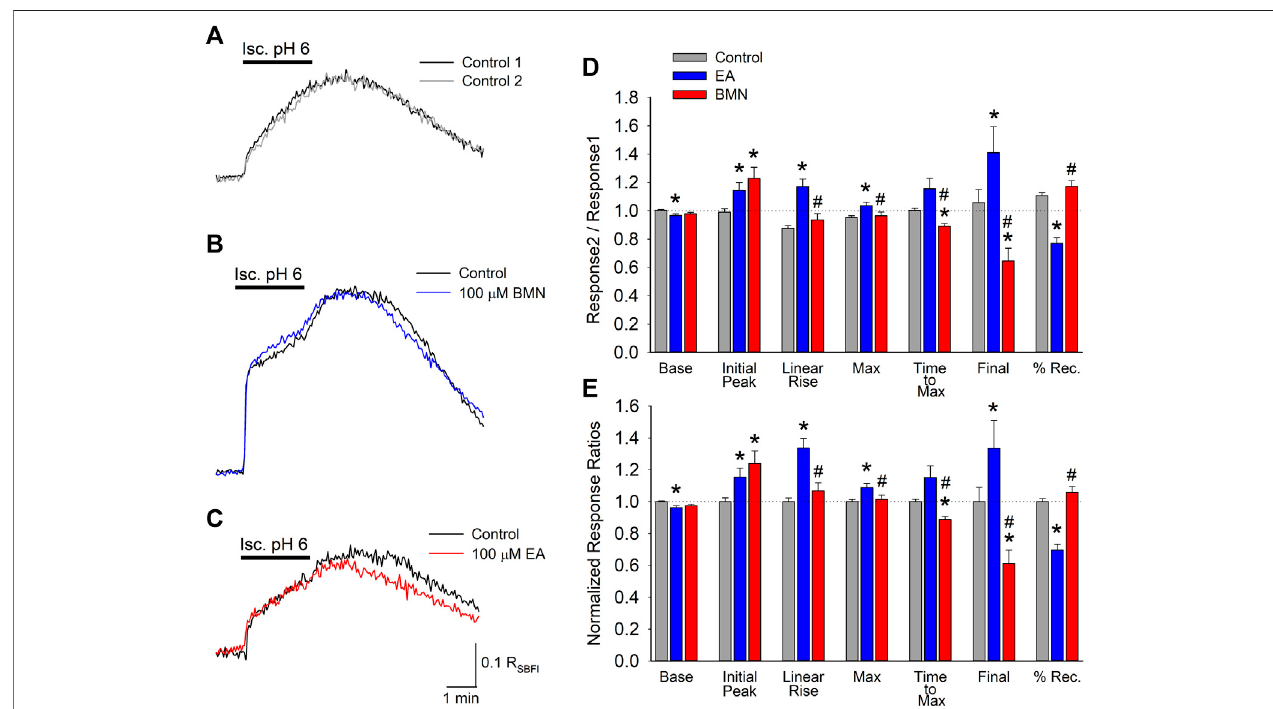
FIGURE2| Increasesin[Na + ] i ,depictedbyR SBFI ,evokedbyconcurrentischemiaandacidosisarenotinhibitedbyNKCC1inhibitors. (A) ,Representativetracesof R SBFI as a function of time recorded from a single neuron during two, 2-min ischemia-acidosis insults with a 20 min recovery period in between. (B) , Representative tracesofR SBFI asafunctionoftimerecordedfromasingleneuroninresponsetotwo,2-minischemia-acidosisapplications, fi rstintheabsence(Control,blacktrace)and 20 min later in the presence of 100 μ M bumetanide (100 μ M BMN, blue trace). (C) , Representative traces of R SBFI as a function of time recorded from a single neuron in response to two, 2-min ischemia-acidosis applications, fi rst in the absence (Control, black trace) and 20 min later in the presence of 100 μ M ethacrynic acid (100 μ M EA, red trace). (D) , Relative mean R SBFI ( ± SEM) measured in the absence (Control) and presence of 100 μ M bumetanide (100 μ M BMN, n (cid:1) 108) or 100 μ M ethacrynic acid (100 μ M EA, n (cid:1) 49). Responses were normalized to control responses in the same cells. Baseline and Initial Peak represent R SBFI values measured immediately prior to and 15 s after initiation of ischemia-acidosis. Max Peak representshighest R SBFI measured during ischemia + acidosis. Recovery wascalculated as ( fi nal-baseline)/(maximum-baseline). (E) , Same data presented in (D) but normalized to the Response2/Response1 ratio for Control. Asterisks denote signi fi cant difference from Control ( p < 0.05) and pound symbol indicates signi fi cant difference between BMN and EA ( p < 0.05). Bars above (A) and (B) indicate duration of ischemia + acidosis (Isc. pH